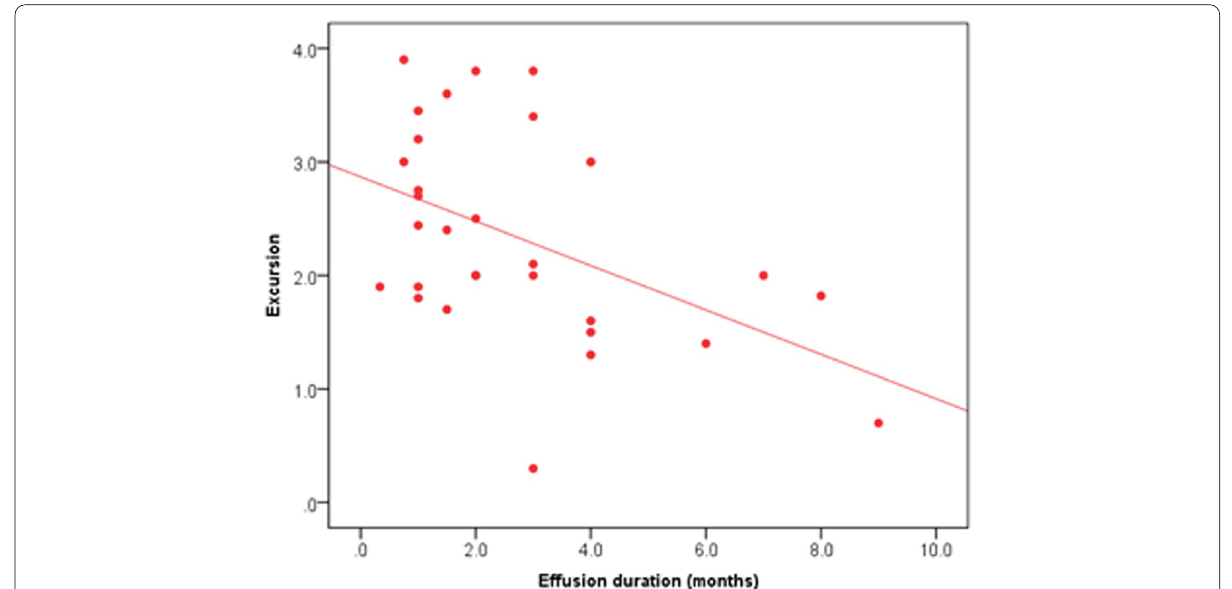
Fig. 2 Significant relation between duration of effusion and diaphragmatic excursion